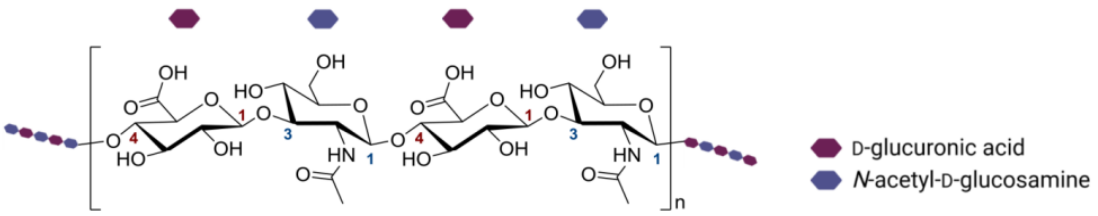
Figure 1. Structure of hyaluronic acid. The figure was created with BioRender.com, accessed on 28 November 2022.